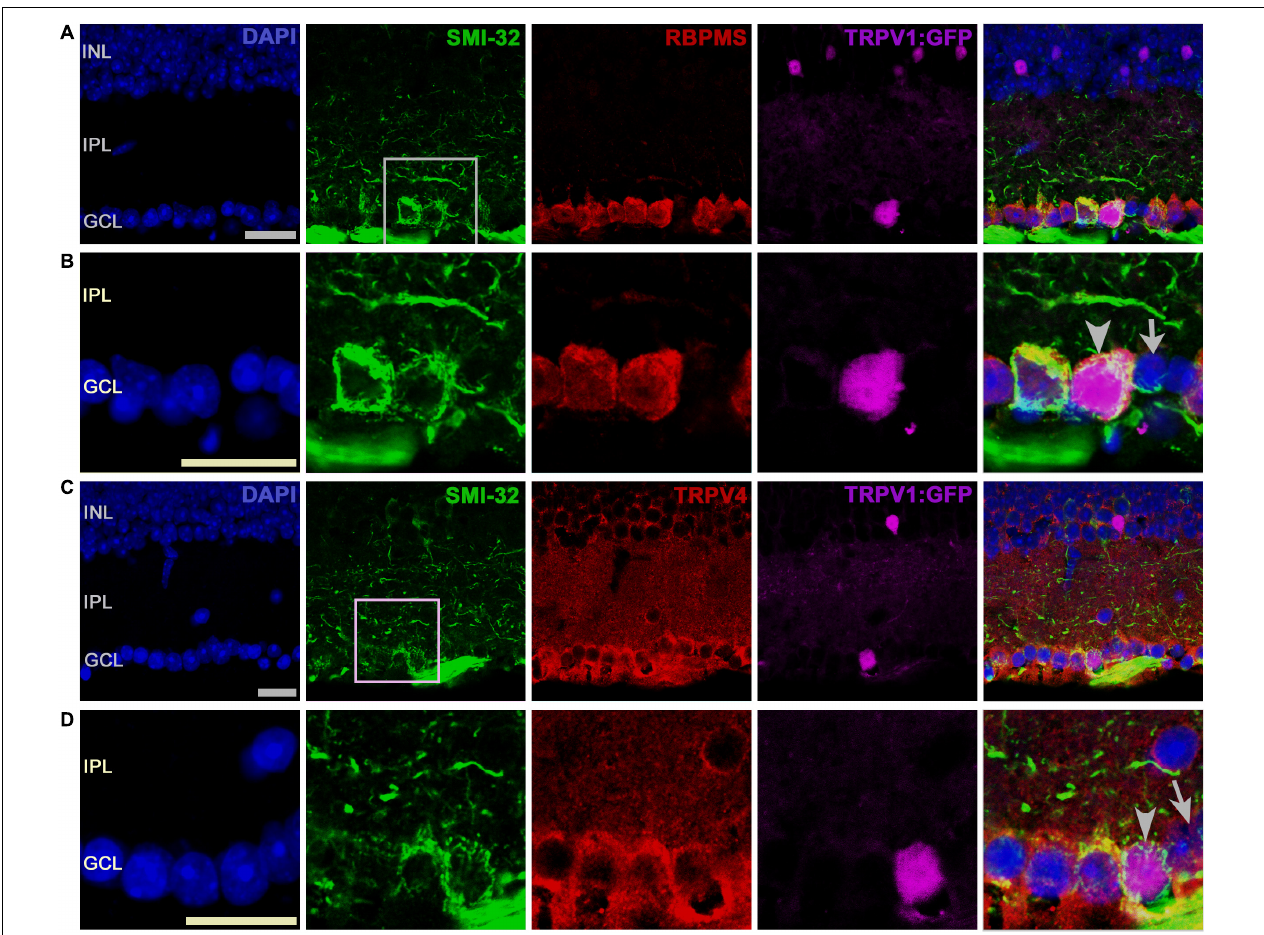
FIGURE 5 | SMI-32 + RGCs coexpress TRPV1 and TRPV4 signals. (A) A representative TRPV1-expressing RGC is labeled by the GFP reporter that was immunopositive for SMI-32 and RBPMS. (B) Inset from A . (C) TRPV1-expressing RGCL neuron is labeled by SMI-32 and TRPV4 ( D , arrowhead) antibodies. The arrow denotes a TRPV4- and SMI-32-immunonegative putative amacrine cell in the proximal INL. Pictures were obtained from one optical section. Scale bars = 20 µ m.